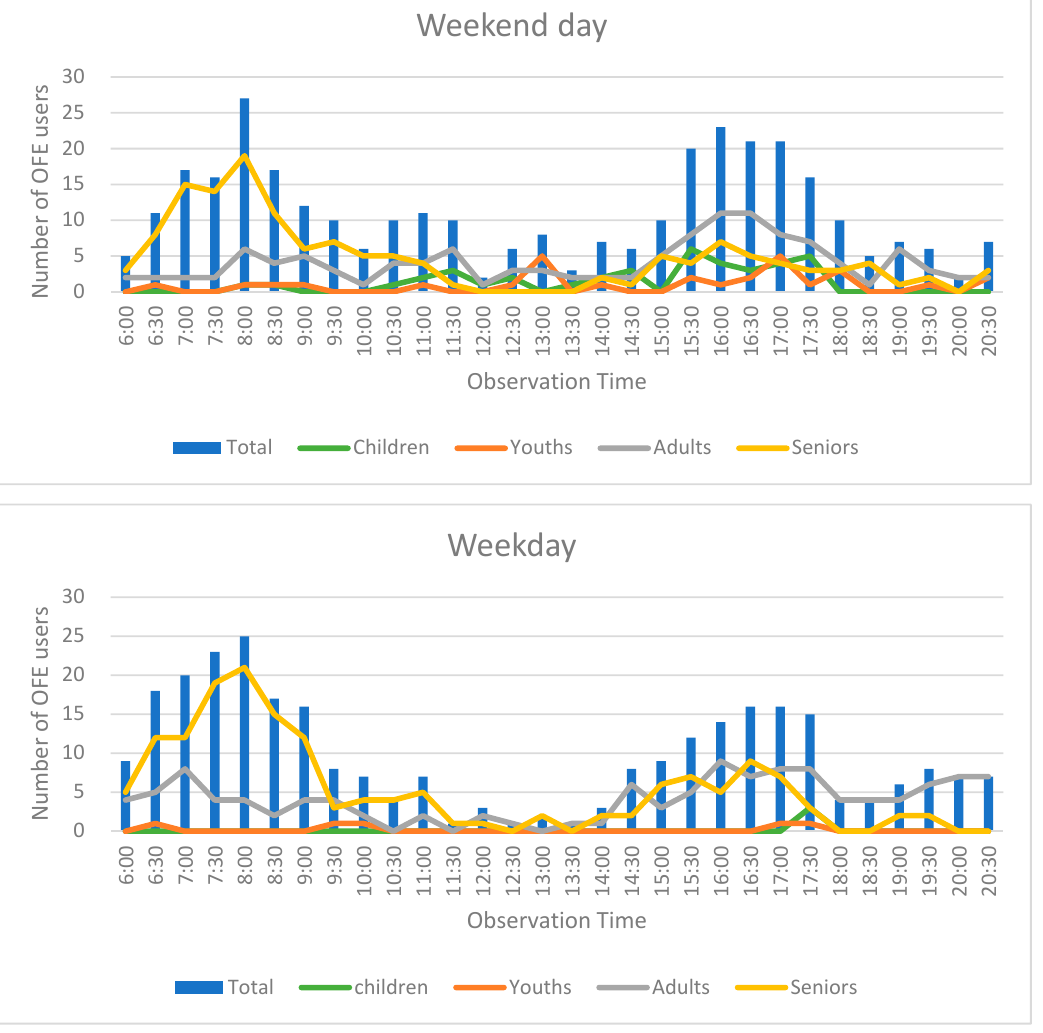
Figure 1. Average number of users of outdoor fitness equipment (OFE) by time of day—weekend vs. weekday. Table 1. Number of OFE users observed in Xihu Park, Tainan, Taiwan, according to age groups during weekdays and weekends from day-long observations.